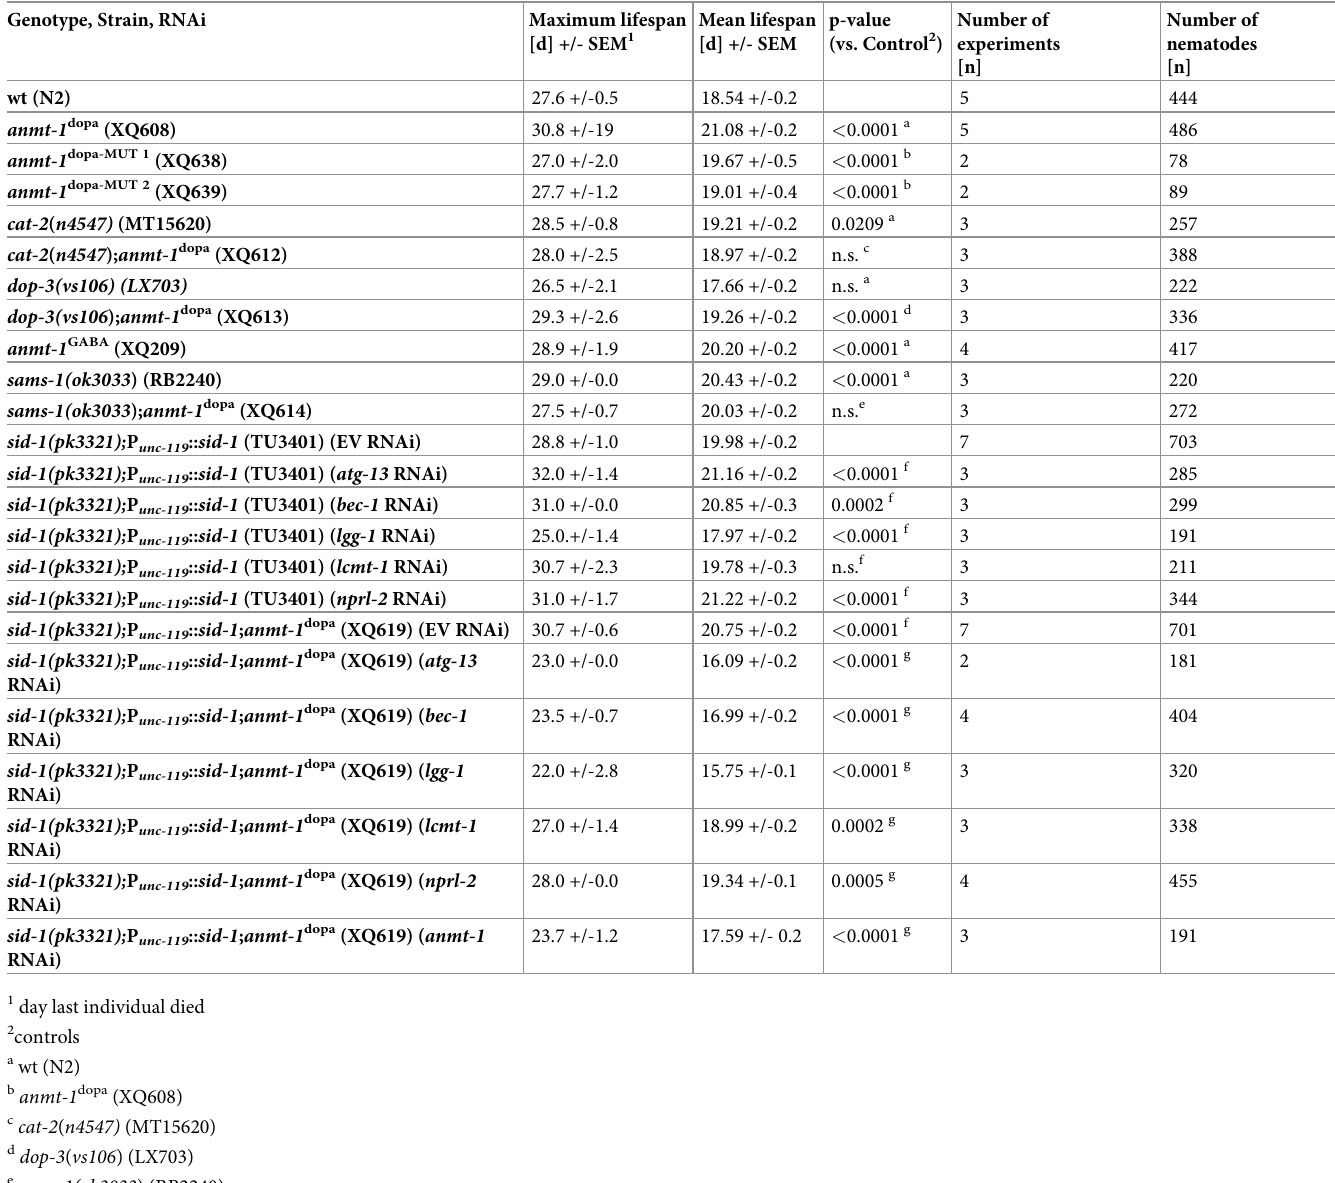
Table 3. Results and statistical analyses of lifespan